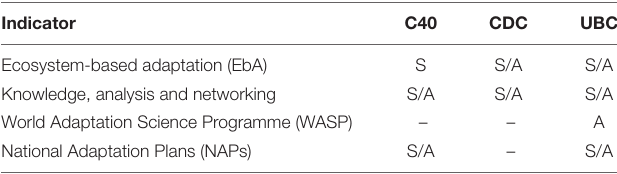
TABLE 6 | Networks and UNEP climate adaptation